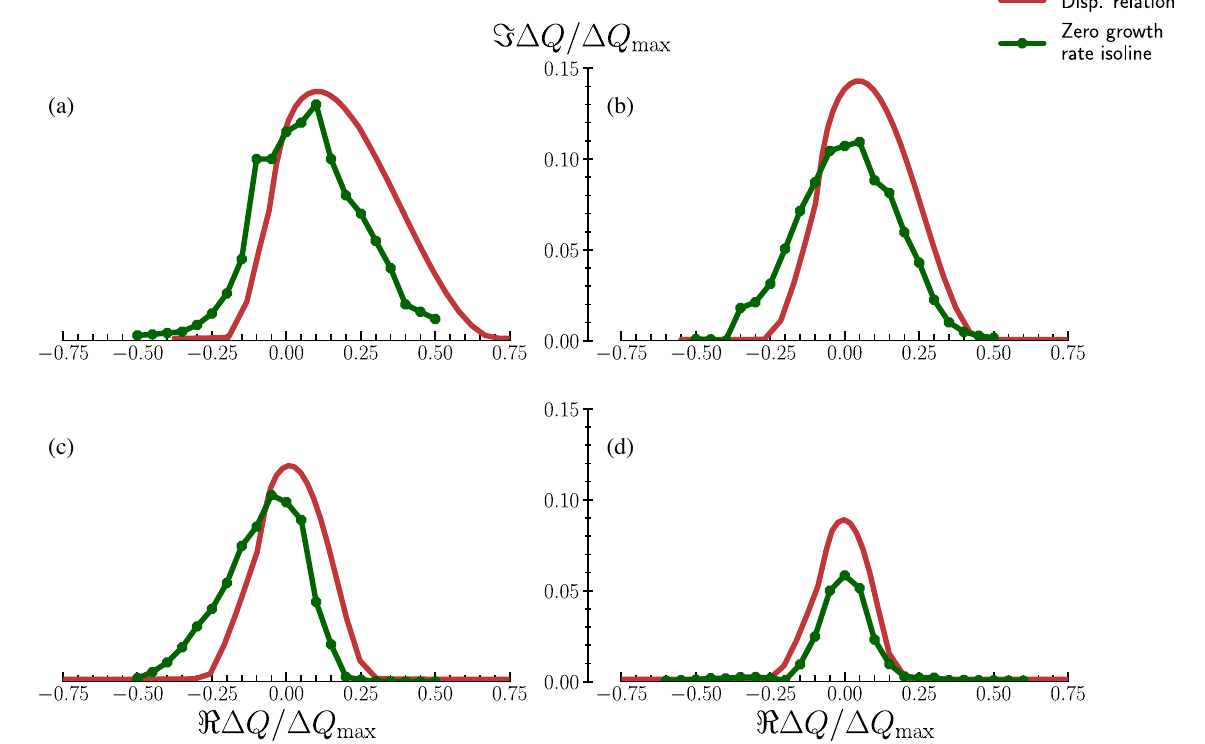
FIG. 5. dc EL stability diagrams from Eq. (22) (red lines) for the head-tail mode l ¼ 0 depending on the electron to ion rms beam = σ . It is compared to the results of simulation scans (green lines) with the rigid mode kick [defined in transverse size ratio r ¼ σ e ⊥ x 0 ;y 0